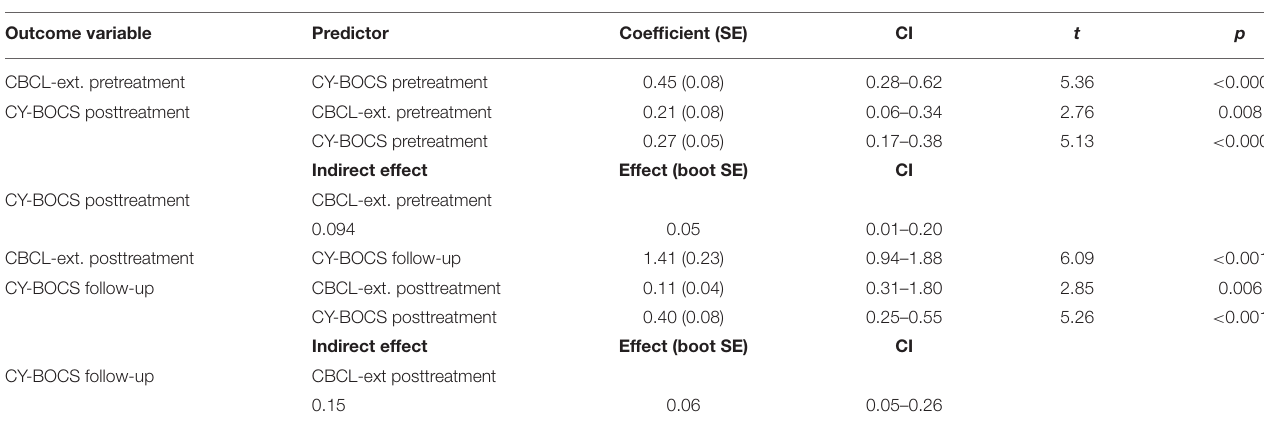
TABLE 4 | Association between CY-BOCS, as mediated by CBCL